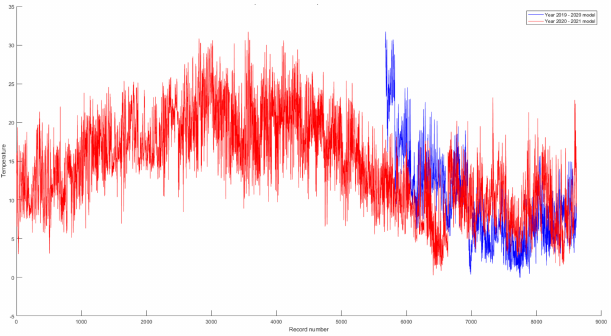
Figure 7. Comparison between the optimised GPR